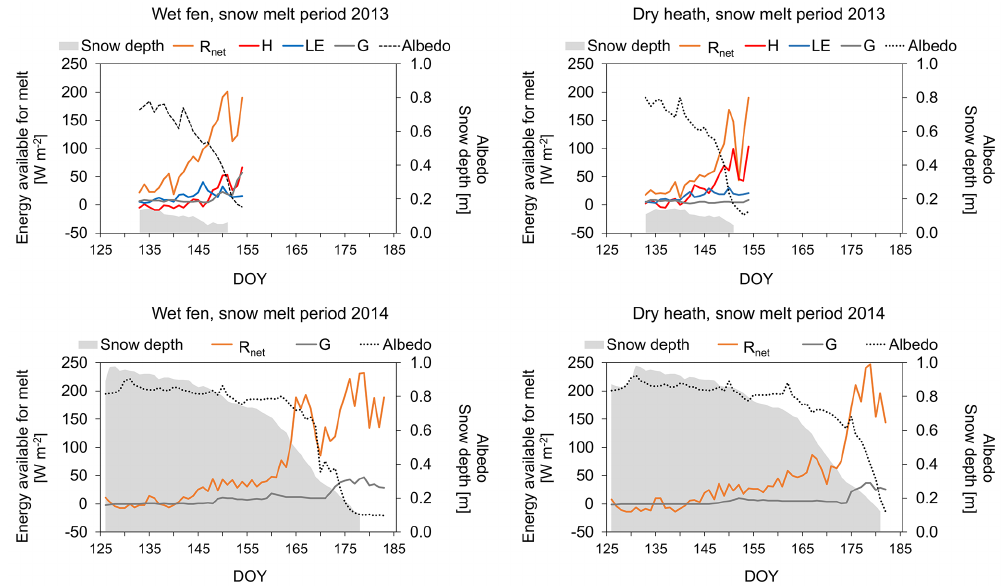
Figure 4. Snowmelt periods 2013 and 2014. Development of mean daily snow cover thickness, albedo, net radiation ( R net ), sensible heat fluxes ( H ), latent heat fluxes (LE) and ground heat fluxes ( G ) at the wet fen (left panels) and dry heath (right panels) during the snowmelt period in 2013 and 2014 and first 5 days of the growing season in 2013 and